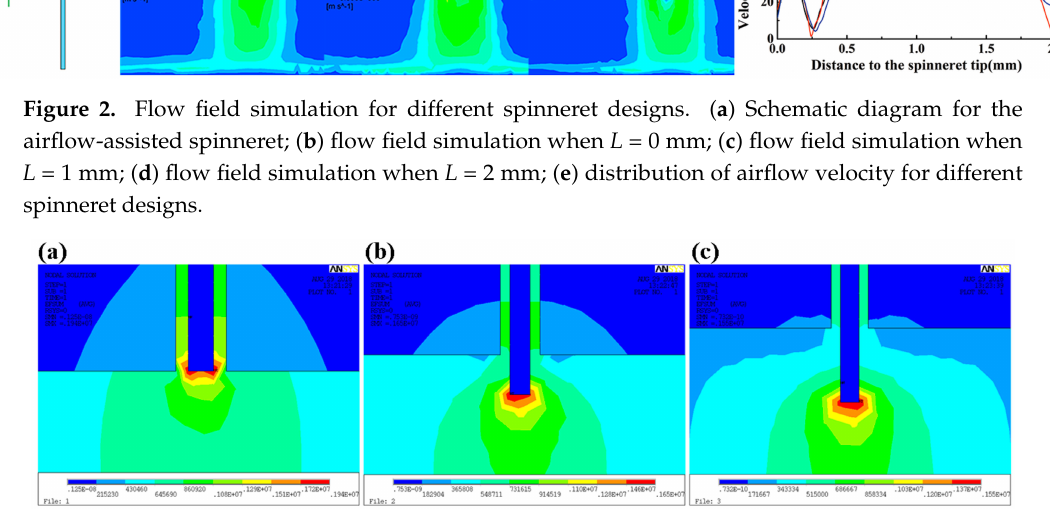
Figure 3. Electrical field simulation for different spinneret designs. ( a ) L = 0 mm; ( b ) L = 1 mm; ( c ) L = 2